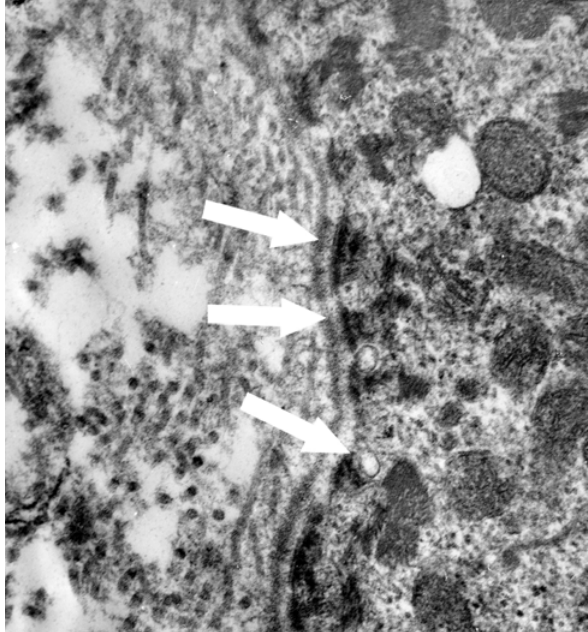
FIGURE 8- TEM micrograph showing intact hemidesmozoms (arrows) (x35970)